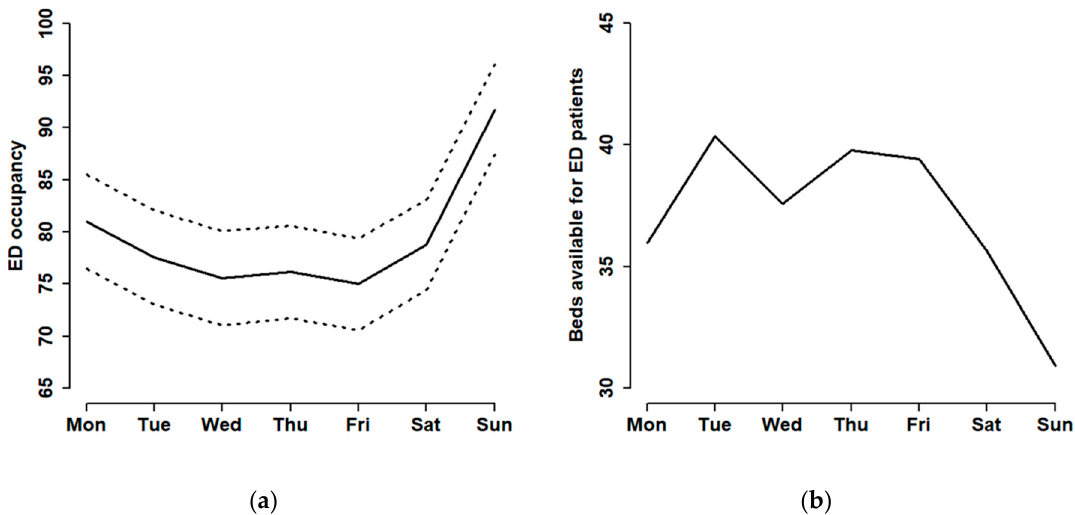
Figure 2. The mean and 95% CI of emergency department (ED) occupancy ( a ), and the mean of numbers of beds available for ED patients ( b ) shown on a daily basis throughout the week.